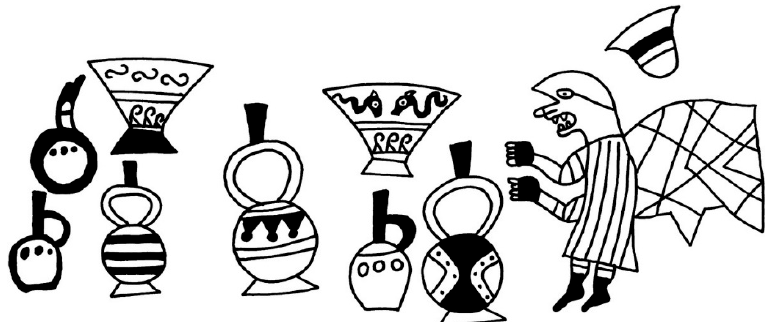
Figure 7. Anthropomorphic Bat and a Variety of Vessels. Dumbarton Oaks Research Library and Collection, The Moche Archives, Drawn by Donna McClelland (Image ID 17149312).